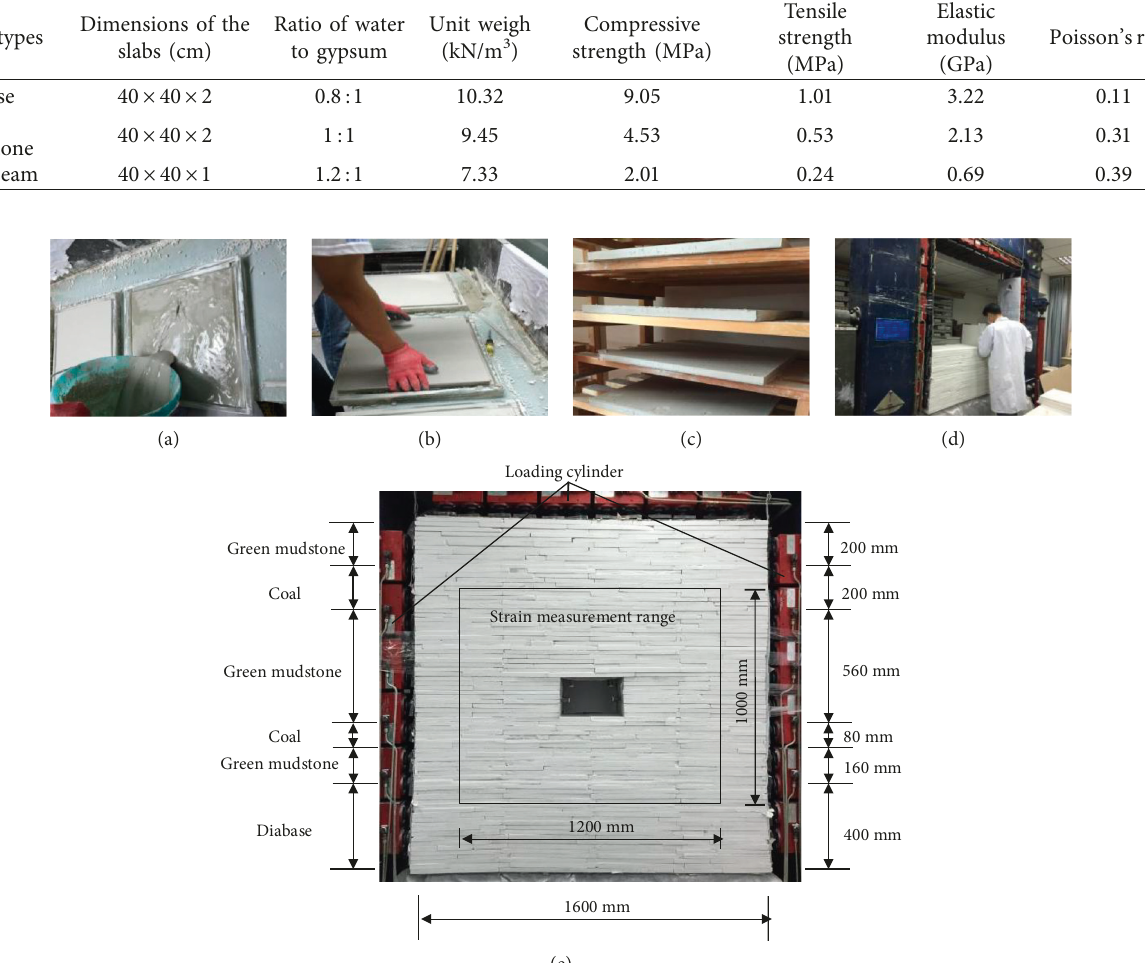
Table 2: Material properties parameters of the elementary slabs.